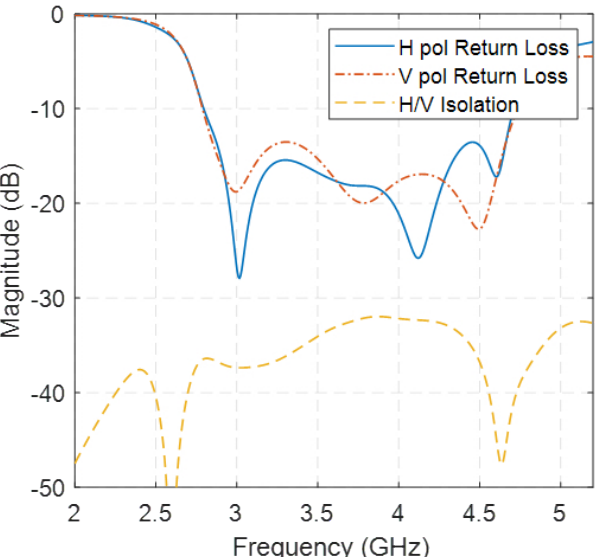
Figure 6. Scaled prototype: H and V polarization return loss and H/V isolation at the end of the